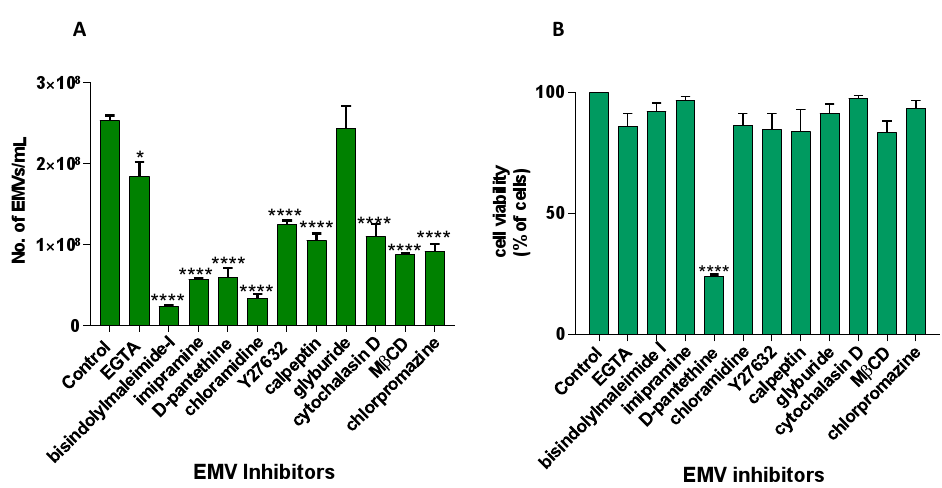
Figure 2. Pharmacological inhibition of EMV release from PC3 cells is highest with Cl-amidine, bisindolylmaleimide-I, and imipramine. ( A ) Using NTA, the most significant inhibition of EMV release from PC3 cells after 24 h was observed in the presence of Cl-amidine, bisindolylmaleimide-I, and imipramine. After 24 h, none of the inhibitors caused any significant reduction in cell viability, ( B ) except for D -pantethine. The experiments were repeated three times, and the data presented are mean ± SEM of the results. (* p ≤ 0.05; **** p ≤ 0.0001).